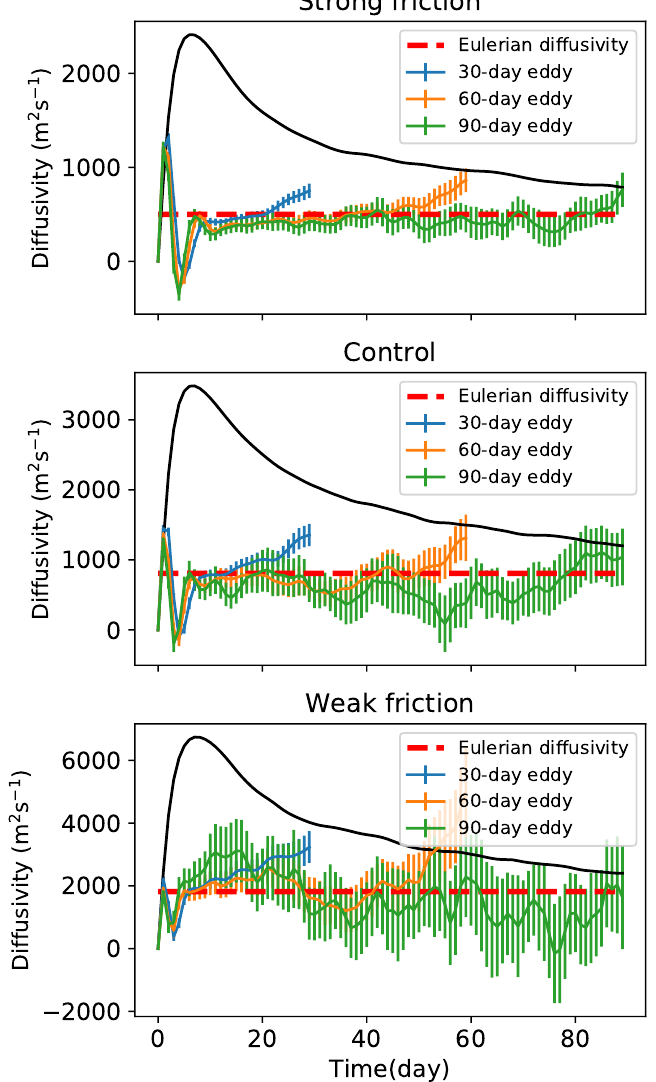
Figure 16. Time series of coherent diffusivity (per coherent particle) in three simulations. Blue, orange, and green lines are 30-, 60-, and 90-day coherent diffusivities, respectively. Error bars give two times the standard error. Black lines indicate the Lagrangian diffusivity averaged over all the particles in the same time period. Red dashed line indicates the Eulerian